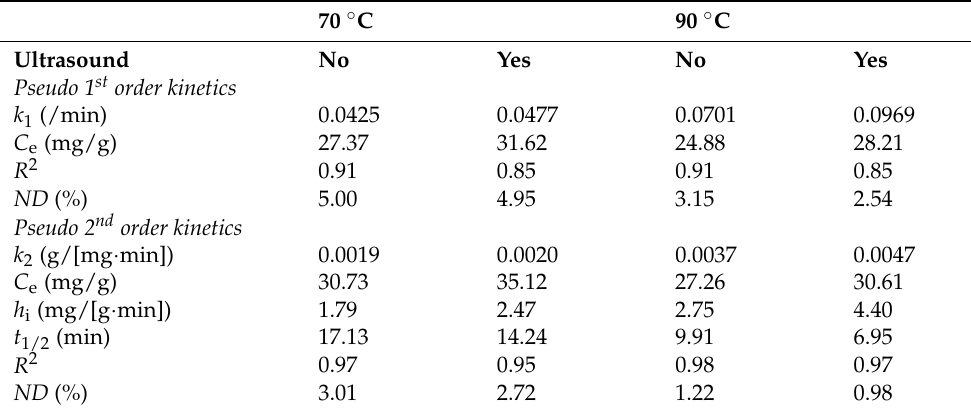
Figure 4. Adsorption kinetics of TA for cationised cotton. Table 3. Kinetic parameters for the adsorption of TA to cationised